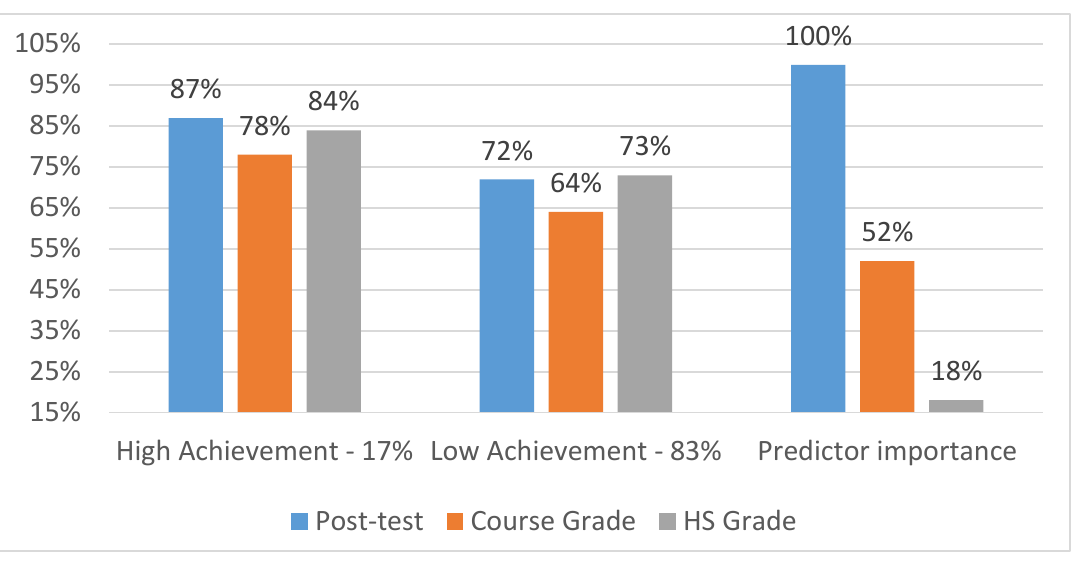
FIGURE 12. CHARACTERISTICS OF ACHIEVEMENT GROUPS 1000